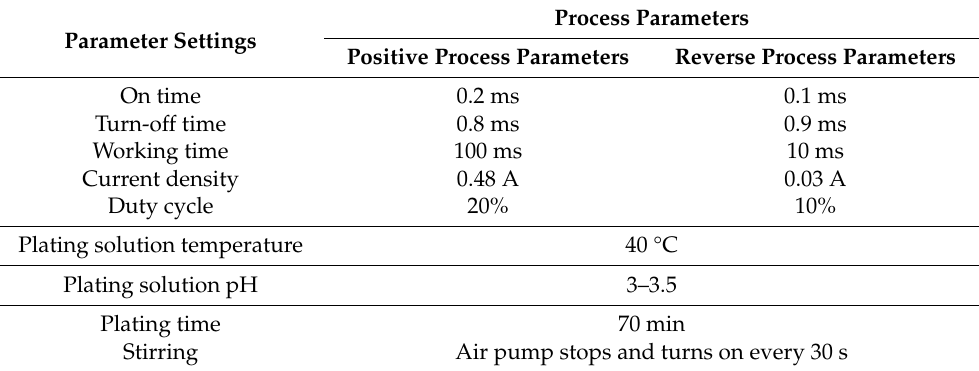
Process parameters for nickel-nanodiamond composite plating by double-pulse